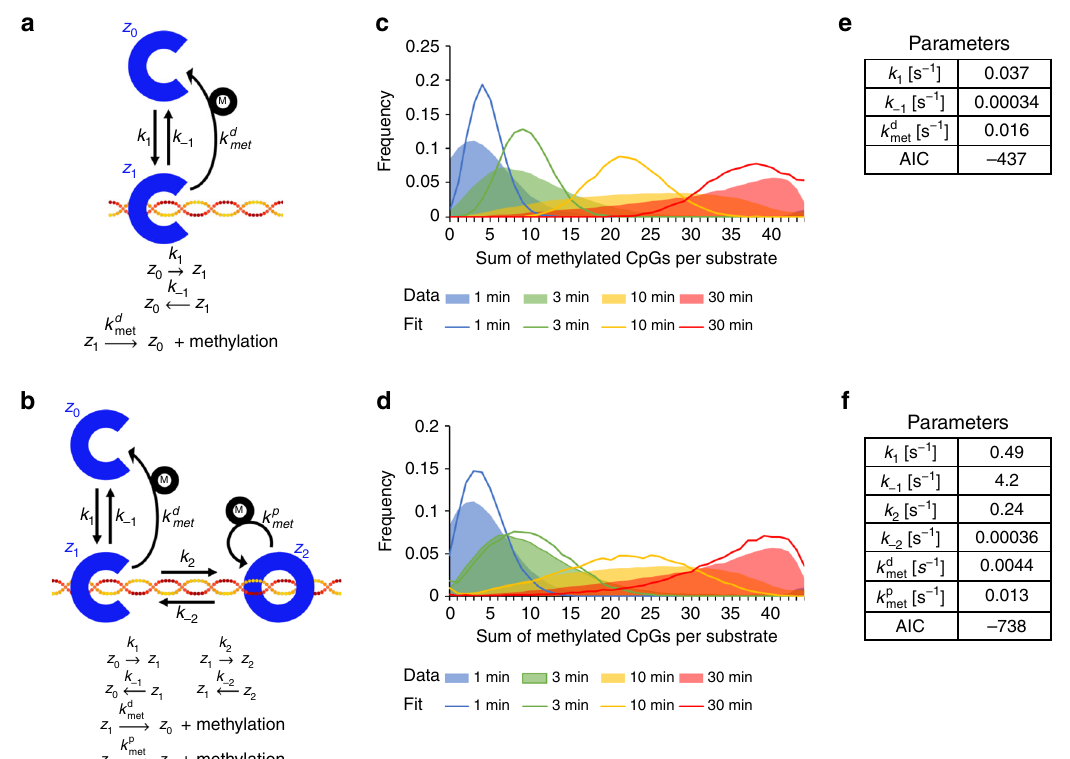
Fig. 2 Fitting of the experimental methylation data reveals a processive methylation mechanism. Schematic drawing of the kinetics models of the DNA methylation mechanism of DNMT1 used for fi tting of experimental data. We used a purely distributive model (Model 1, a ) or a mixed model including distributive and processive methylation (Model 2, b ). The corresponding reactions are indicated below the schemes. Comparison of the experimental data (colored areas) and best fi t (colored lines) for the distributive ( c ) and mixed ( d ) models. Model parameters after fi tting for the distributive ( e ) and mixed ( f ) models. AIC, Akaike Information